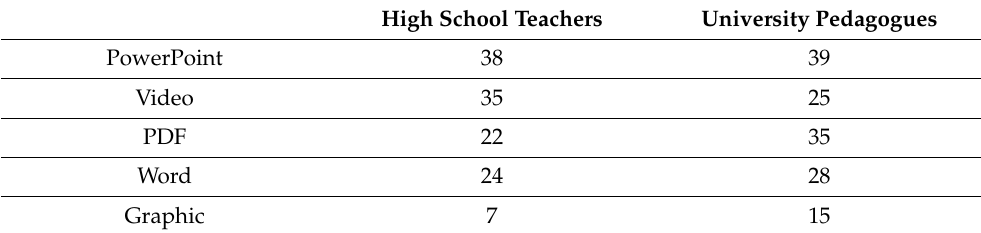
Table 3. Lesson Presentation.